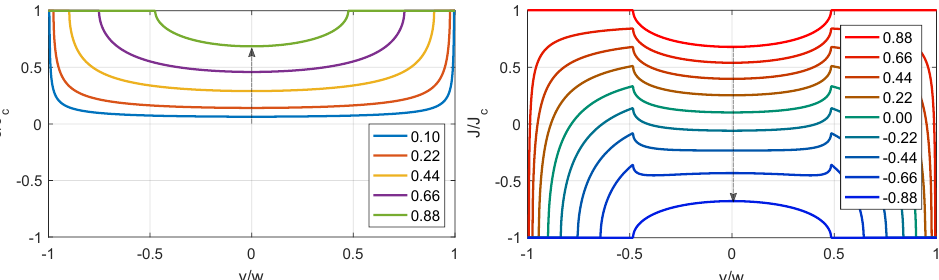
Figure 4: Current distribution profile forming in a rectangular cross-section super- conductor extending to infinity: (Left) shows the current distribution across the en- tire wire width 2 w increased from the virgin state to a maximum transport current / I = 0.88 and (Right) when decreased down to I of I t c indicate the direction of current